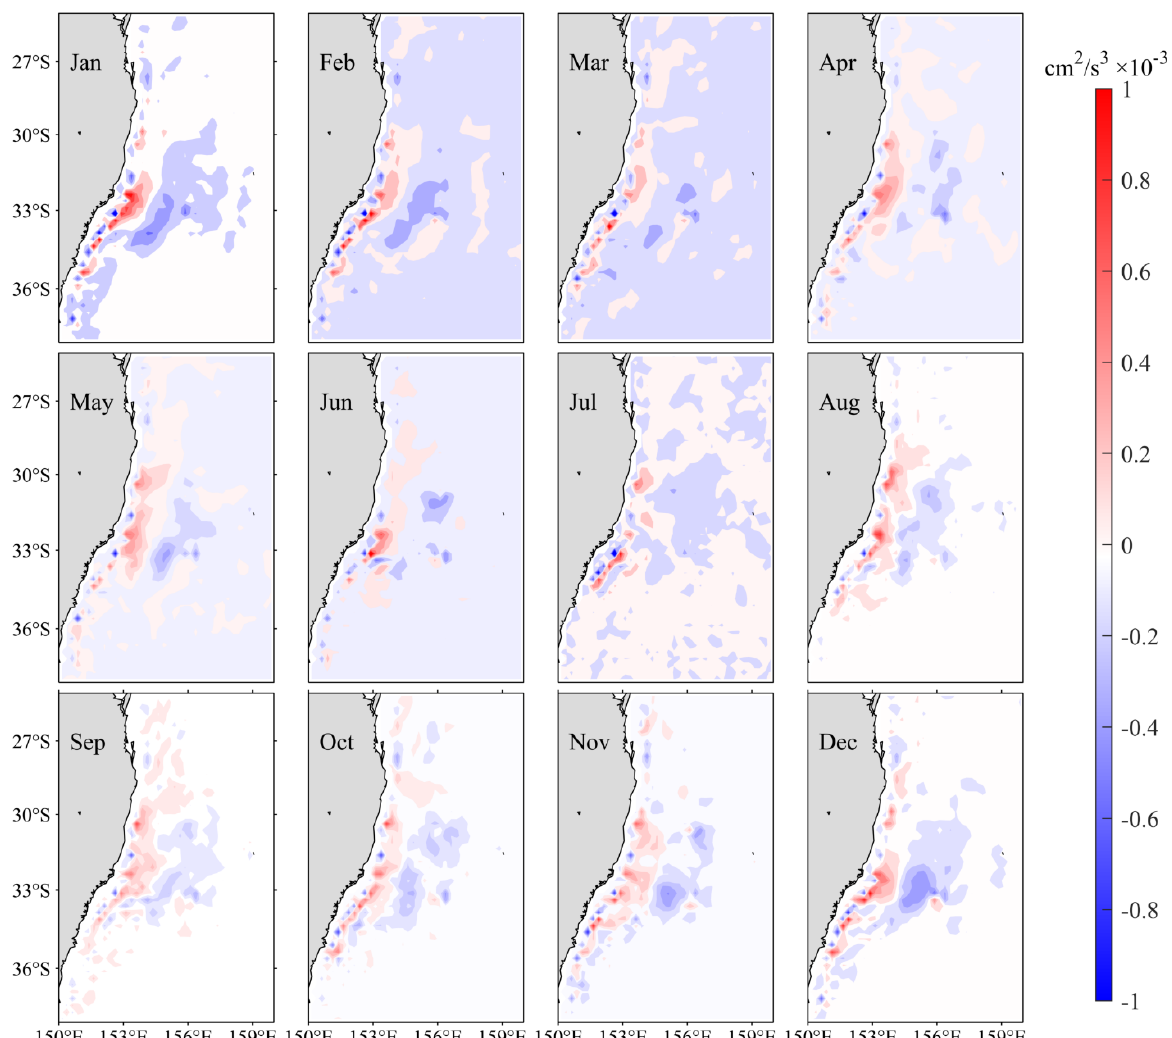
Figure 8. Monthly mean climatological baroclinic conversion rate (BCR) distribution averaged in the upper 500 m layer. See Equation (5) for the definition of BCR.